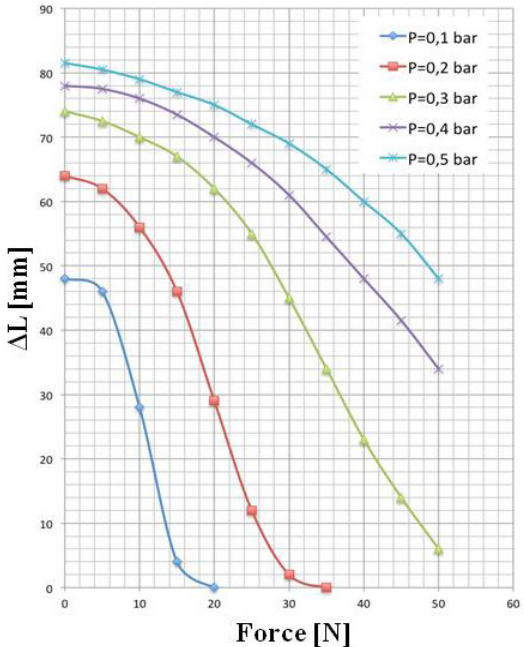
Figure 14. Force-elongation tests on a bellows